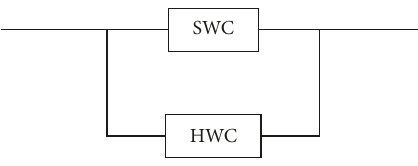
Figure 3: Main block diagram of module 𝑀 𝑁,1